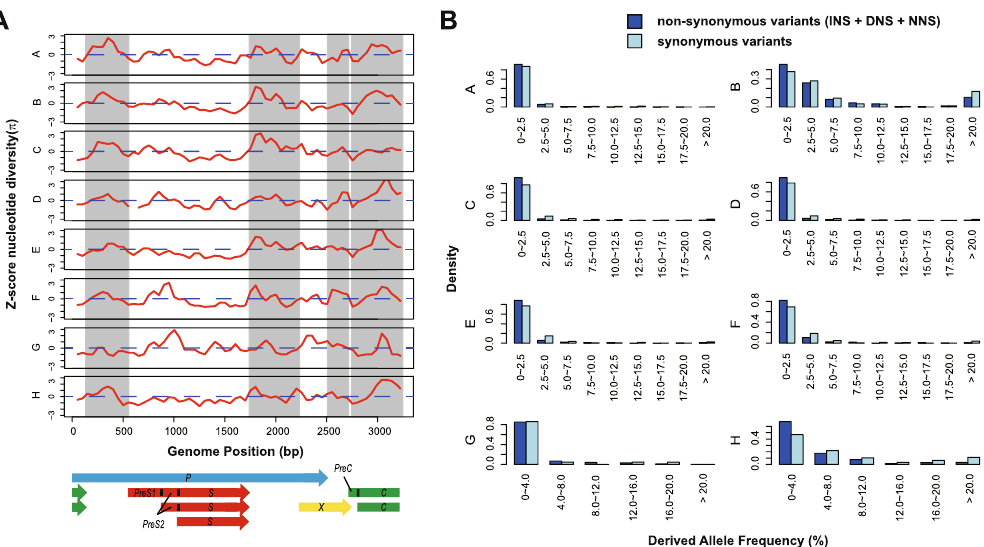
Figure 2. Polymorphisms within HBV genotypes in presence of constraints. ( A ) Z-transformed pair-wise nucleotide difference Z π was displayed for eight genotypes (A–H) over a 100-bp sliding window with a step size of 50 bp. Regions without gene overlaps are highlighted with grey background. ( B ) Distribution of derived allele frequency (DAF) of non-synonymous variants and synonymous variants, where non-synonymous variants comprise INS, DNS and NNS variants. In particular, histogram of genotypes A–F were showed in a high resolution with more separate intervals of variant frequencies (each bar represents an interval of 2.5%), while distributions in genotypes G, H were showed in low resolution (4%) because of small sample